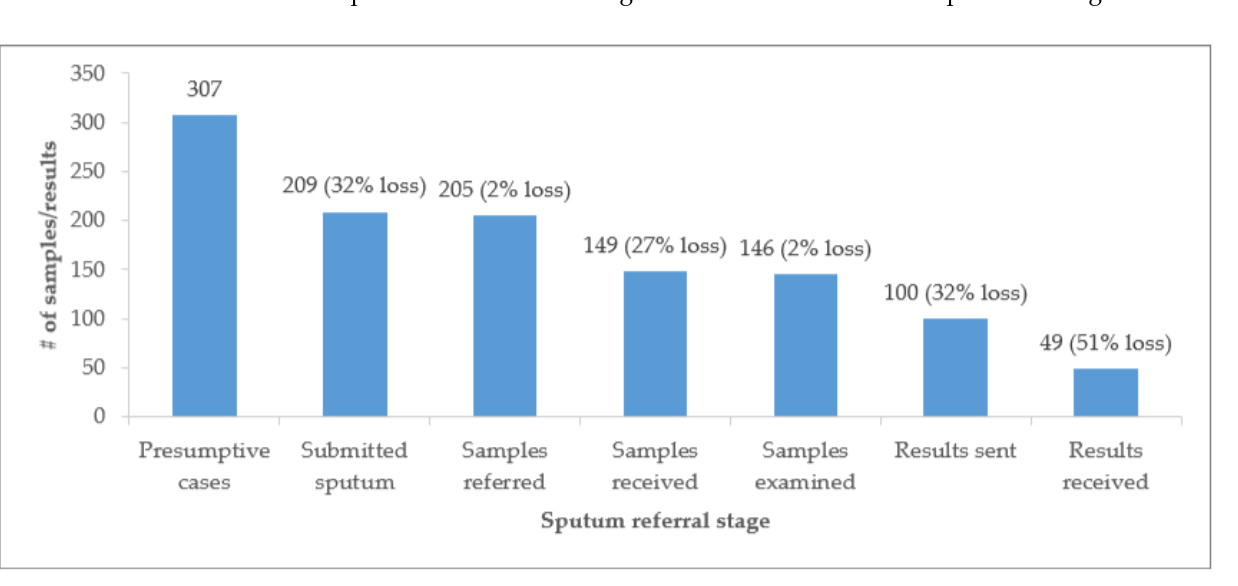
Figure 2. Sputum sample referral cascade for patients presenting with symptoms suggestive of TB in ten public health facilities in Mpulungu District (April–September 2018).